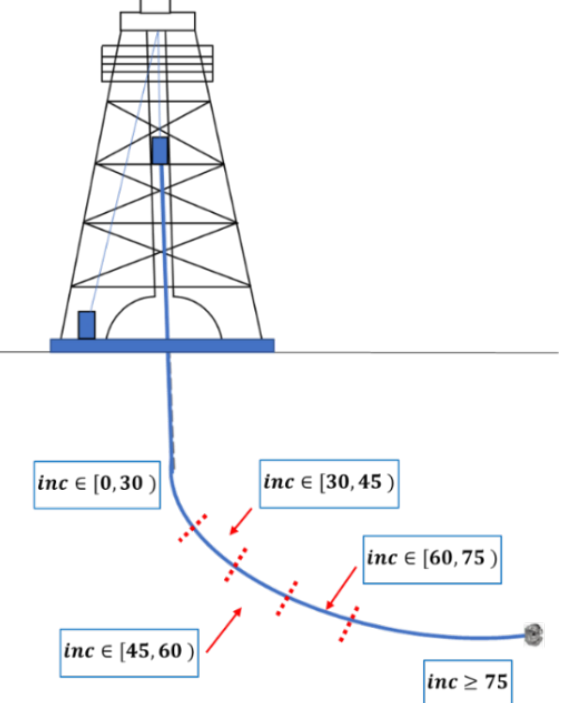
Figure 6. Strategy for defining state vector components based on wellbore inclination angles.